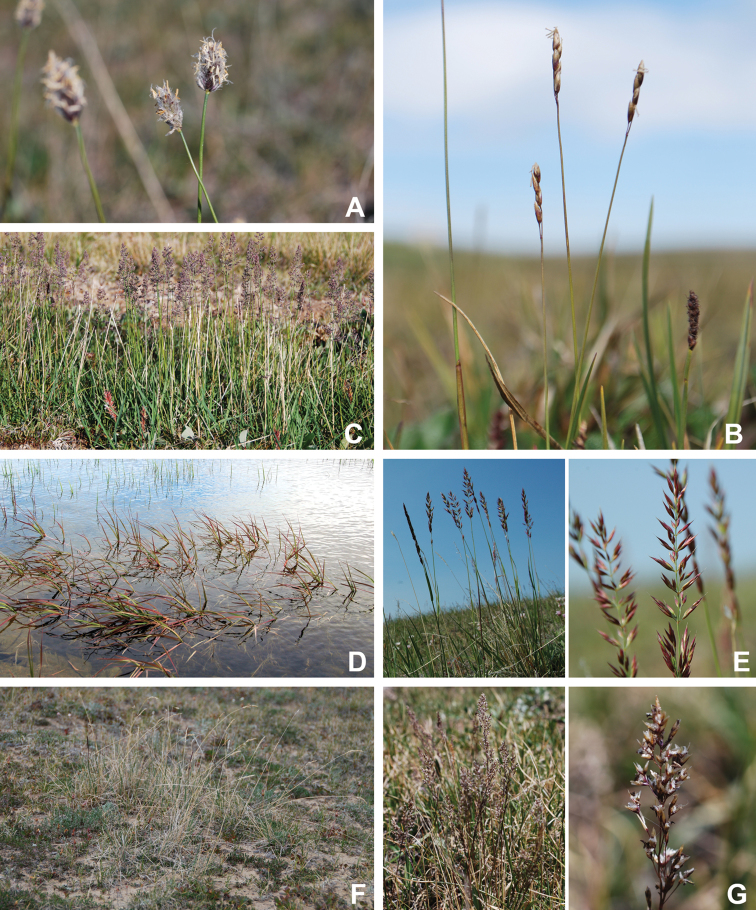
AAlopecurus
borealis inflorescences, Gillespie et al. 9650BAnthoxanthum
arcticum habit CArctagrostis
latifolia
subsp.
latifolia habit, Gillespie et al. 9983DArctophila
fulva habit, Gillespie et al. 8441ECalamagrostis
purpurascens habit (left), inflorescence (right), Gillespie et al. 8115FCalamagrostis
stricta
subsp.
groenlandica habit, Gillespie et al. 9908GDeschampsia
brevifolia habit (left), inflorescence (right), Gillespie et al. 9856. Photos A, C, F, G by J.M. Saarela, B by B.A. Bennett and D, E by R.D. Bull.